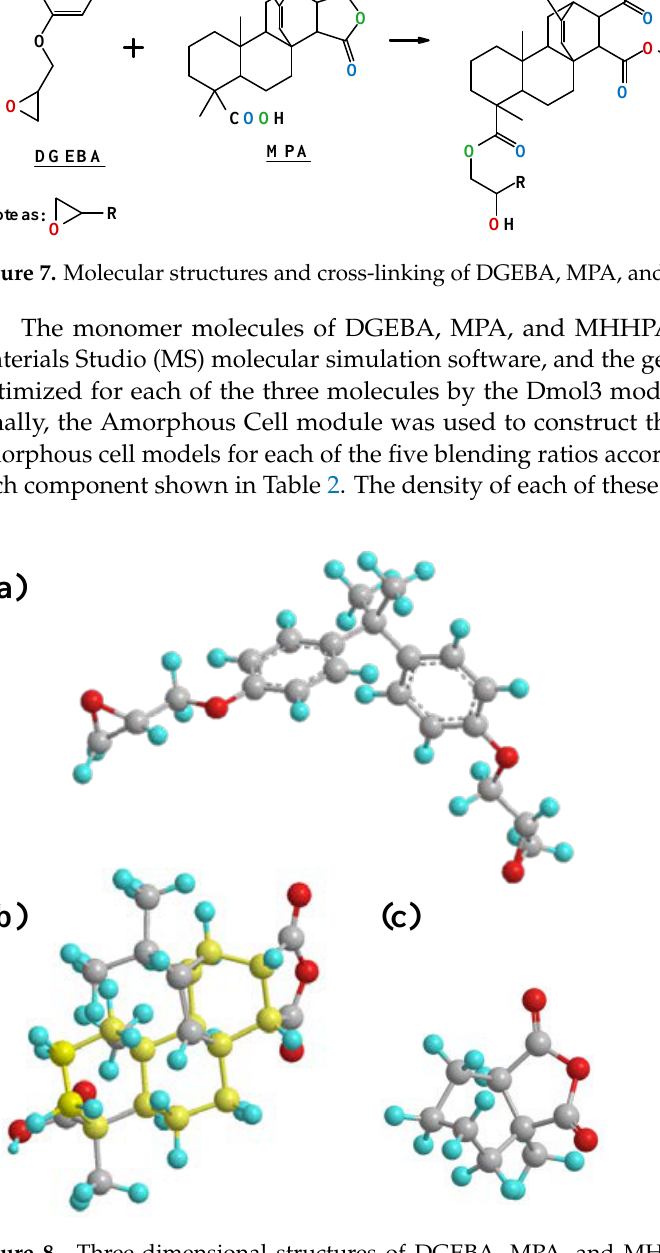
Figure 8. Three-dimensional structures of DGEBA, MPA, and MHHPA. ( a ) DGEBA, ( b ) MPA, ( c ) MHHPA. In the figure, the gray spheres represent C atoms; the yellow spheres represent the C atoms that make up the phenanthrene ring; the blue spheres represent H atoms; and the red spheres represent O